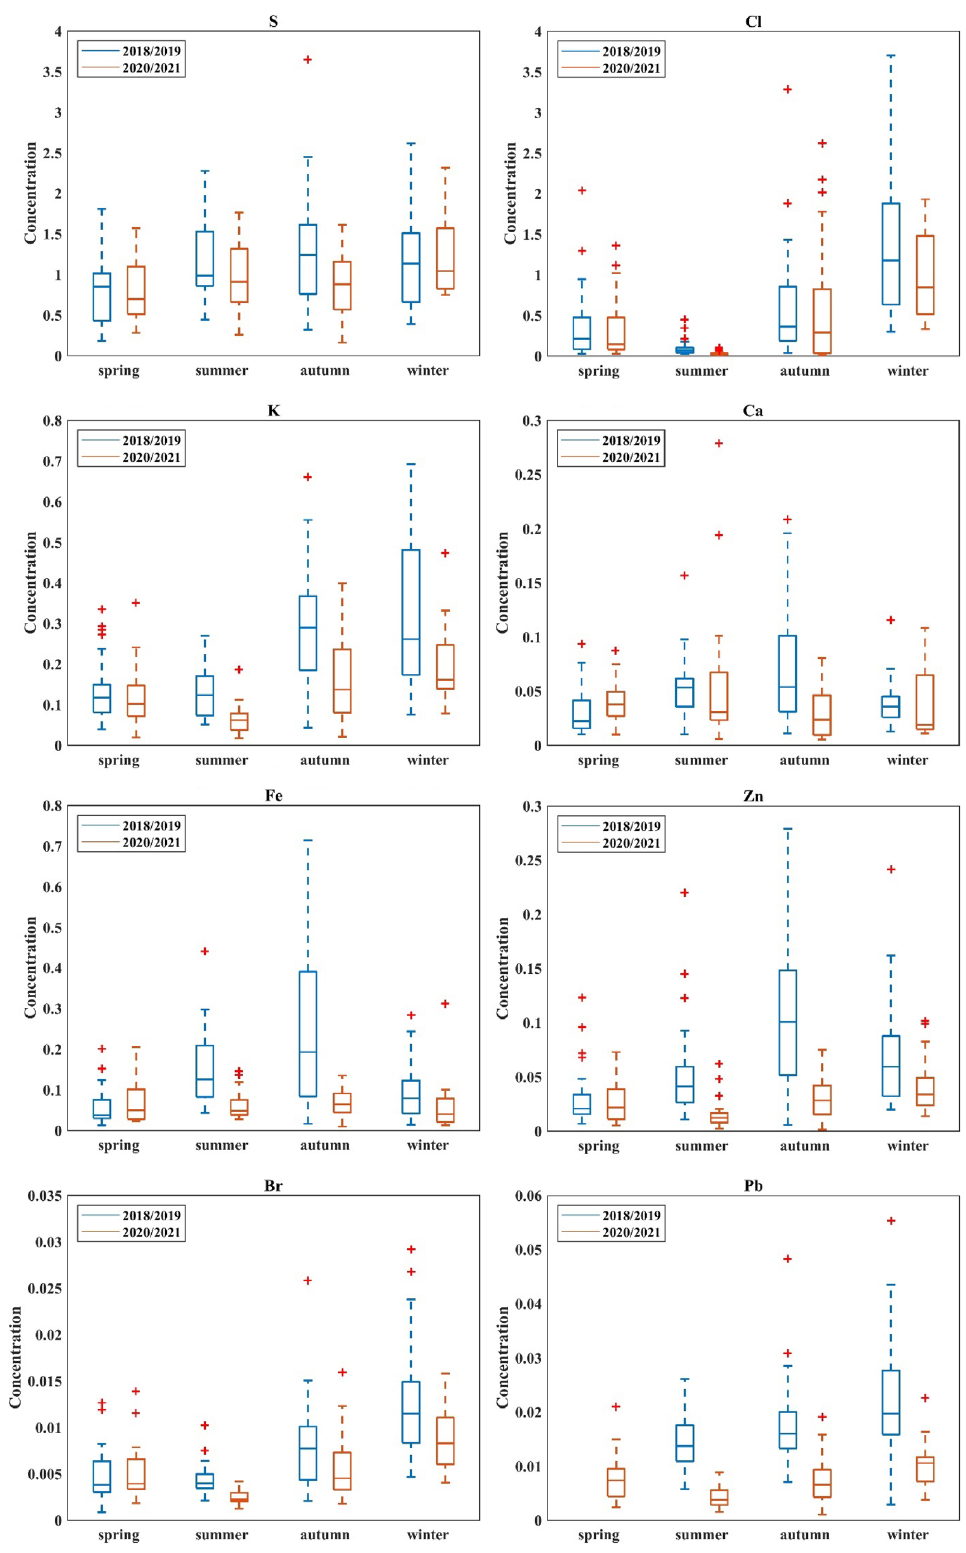
Figure 4. Box plots with interquartile spans and median, minimum, maximum values of elements concentrations for 2018/2019 and